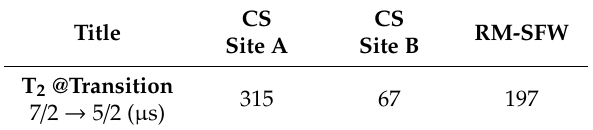
Table 5. Spin-spin relaxation time constants T 2 of transitions from Table 1 at 310